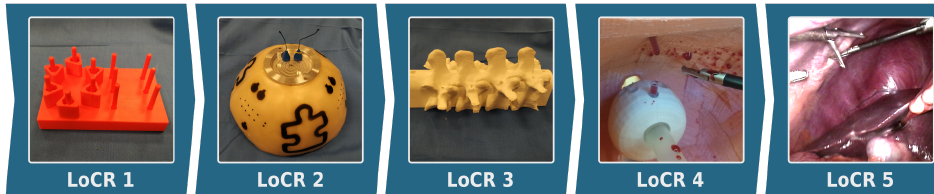
Figure 2. The Level of Clinical Relevance (LoCR) scale for Robot-Assisted Minimally Invasive Surgery (RAMIS) with examples. LoCR 1: 3D printed board for the peg transfer training task, designed by Hwang et al. [27]; LoCR 2: Fundamentals of Robotic Surgery (FRS) training dome; LoCR 3: 3D printed bone phantom for drilling tasks; LoCR 4: anatomically relevant silicone pelvis phantom [36]; LoCR 5: in vivo human surgical environment [37].